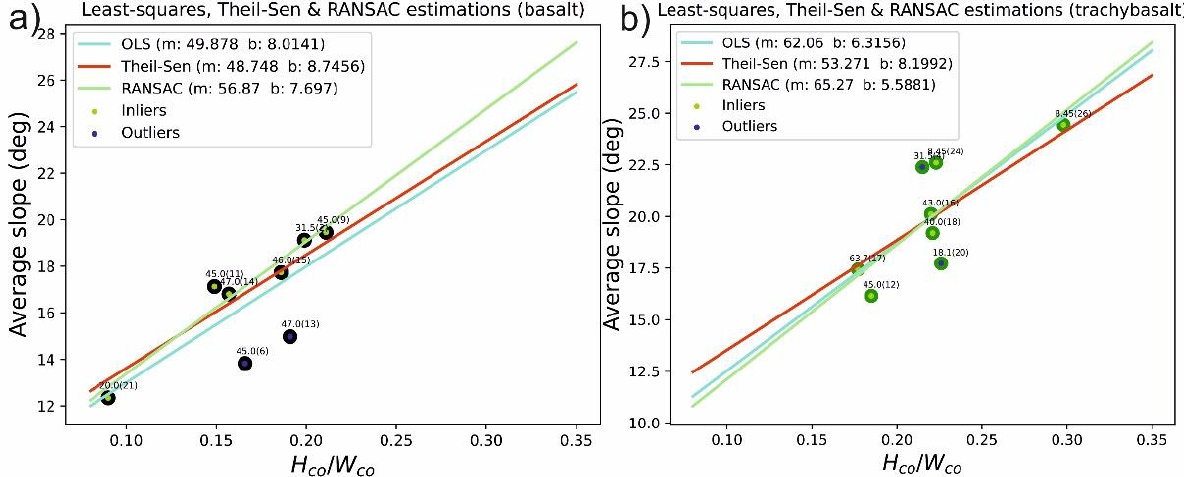
Figure 13. Modeling of average slope and H co / W co relationship of ( a ) basalt ( b ) trachybasalt cones using the ordinary least squares method (OLS), Theil–Sen estimation, and RANSAC algorithm. The values indicated are the ages of the cones, and the IDs (see Table 1) are indicated in brackets.